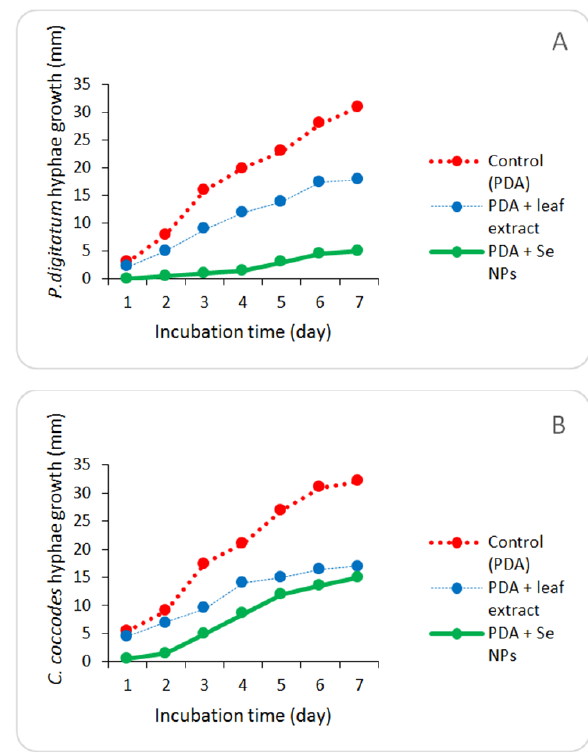
Figure 10: Mycelia growth inhibition of the synthesized Se NPs toward Penicillium digitatum (a) and Colletotrichum coccodes (b) after 7 days of incubation at 26 ± 2°C. Data are the mean value of three replicates (each replicate contains four